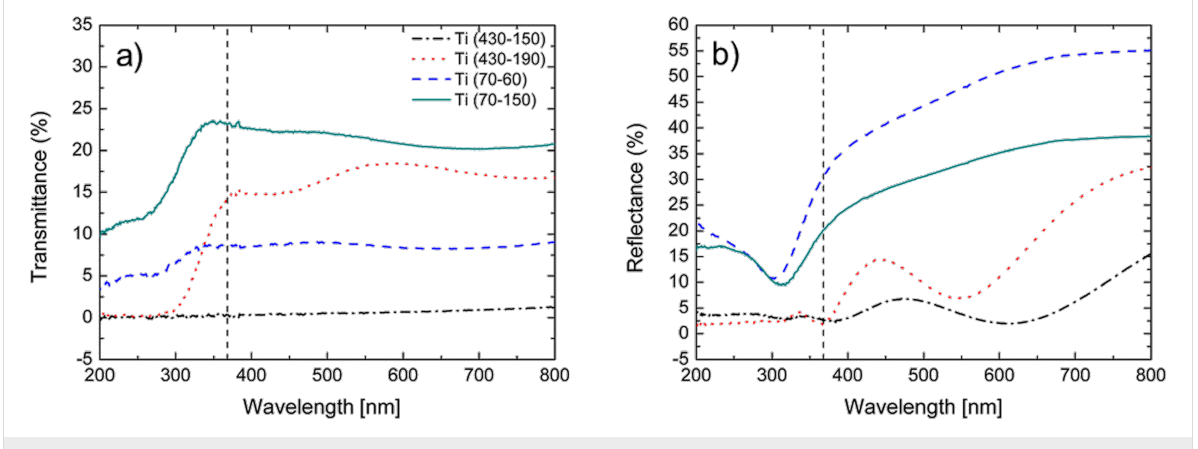
Figure 4: Transmittance (a) and reflectance (b) measurements in the range of 200–800 nm. The vertical lines mark the wavelength of the UV-A light source used for the photocatalytic experiments.